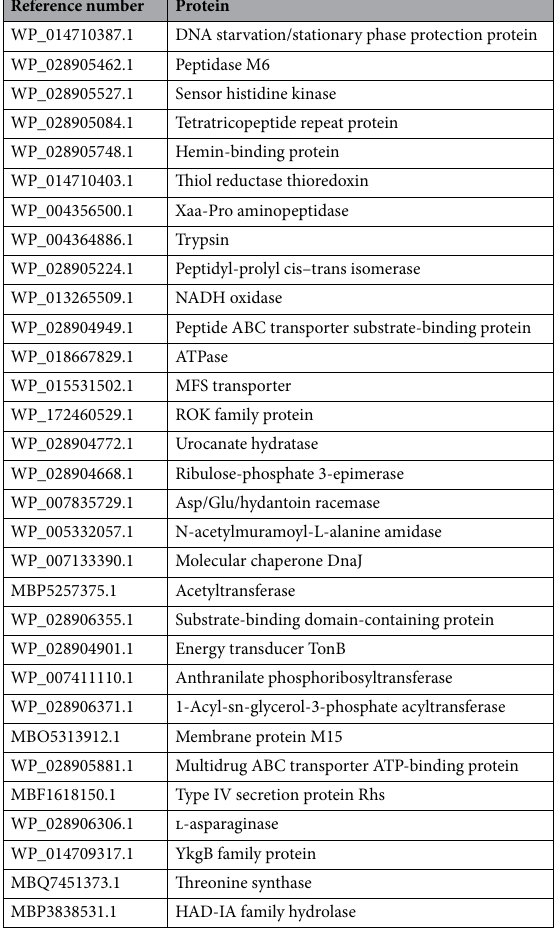
Table 1. Proteins with predicted virulence properties from P. intermedia